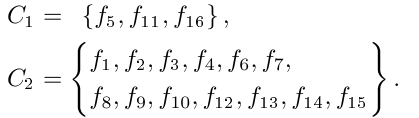
video in front of TDTU-Nguyen Huu Tho street at night. Some sample images are represented in Fig. 6. Firstly, these images are digitized to es- timate corresponding PDFs. Then, these PDFs